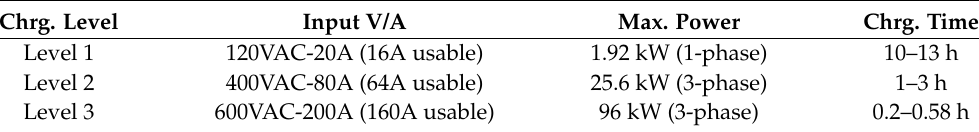
Table 1. Charging levels for EVs. Chrg.